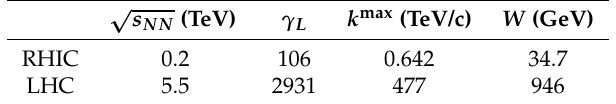
Table 1. Parameters of ultraperipheral collisions (UPCs) Au + Au at RHIC and Pb + Pb at the